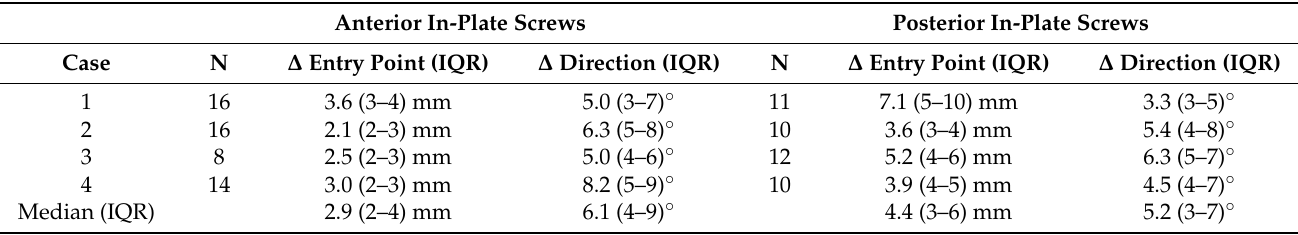
Table 1. In-plate screw difference. The number of screws (N), the median difference in entry point ( ∆ position) and the median difference in direction ( ∆ direction) between the preoperative and postoperative 3D model of the in-plate screws for each session with the interquartile range (IQR).